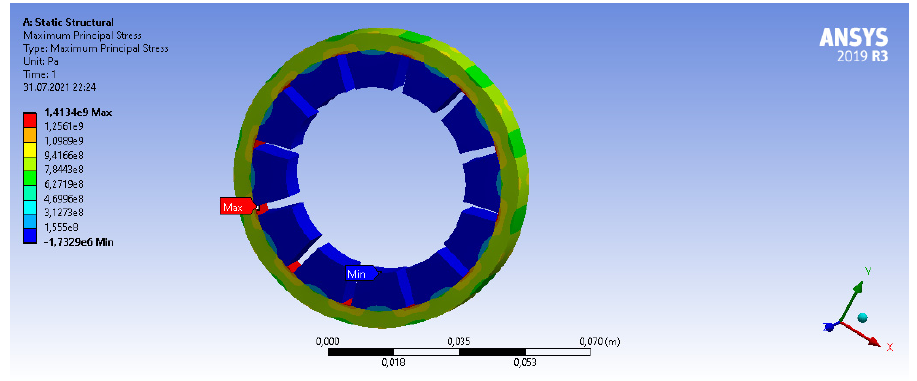
Figure 7. Results of mechanical calculation in the Ansys software environment.